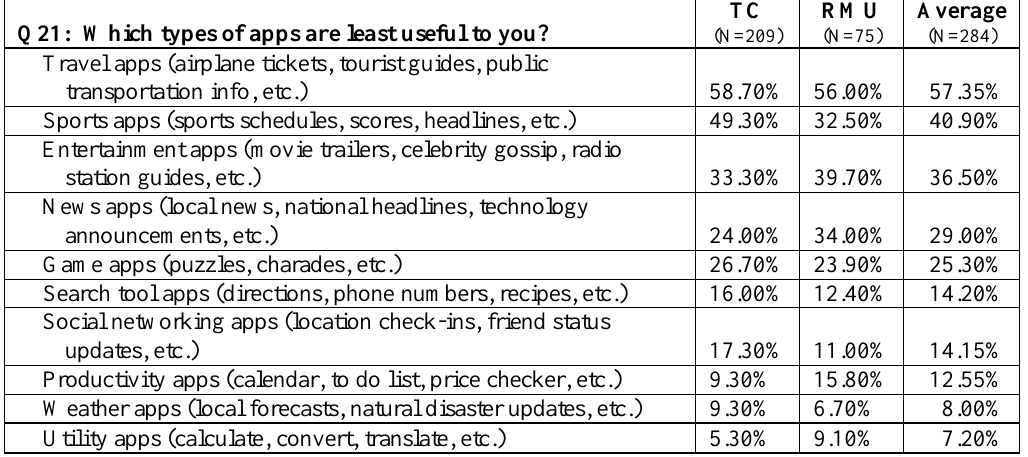
Table 4. RQ4: Least useful